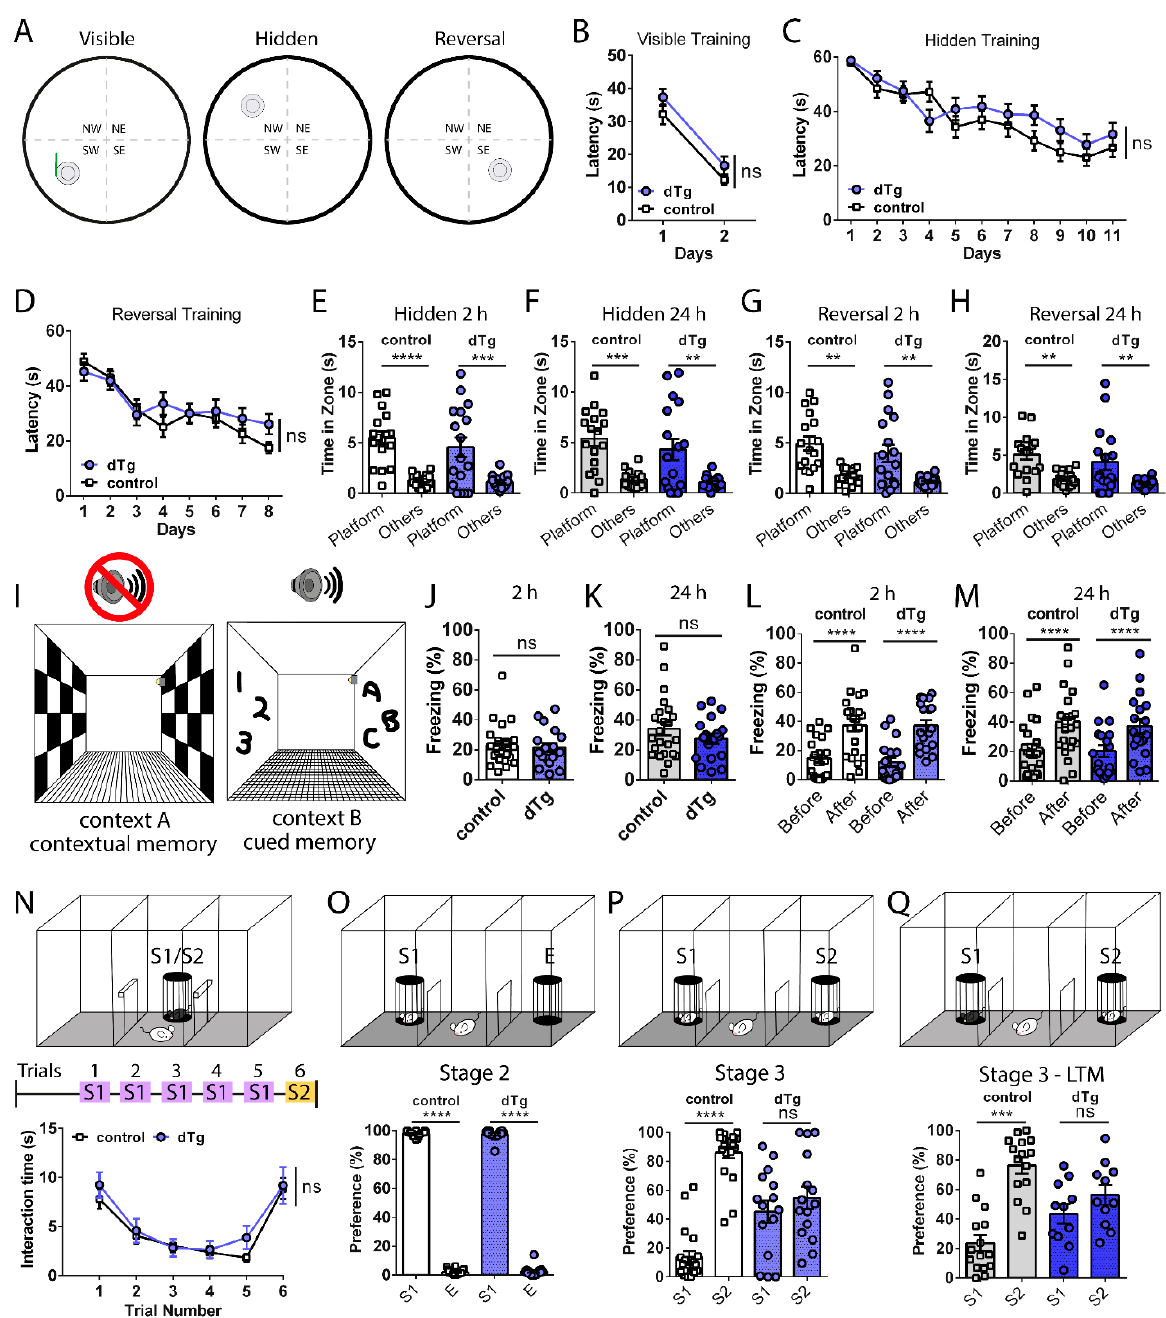
Figure 4. Impaired social recognition memory in three-chamber social tests, but normal spatial and fear learning and memory, in dTg mice. ( A ) Schematics of visible, hidden, and reversal MWM training layout. No differences between control ( n = 19) and dTg ( n = 22) mice in escape latency during ( B ) visible platform (F (1,39) = 143.7; p < 0.0001, post hoc control p < 0.0001, dTg p < 0.0001; between genotypes F (1,39) = 2.280; p = 0.1391), ( C ) hidden platform (between genotypes F (1,39) = 0.9090; p = 0.3463), and ( D ) reversal platform (between genotypes F (1,39) = 0.3892; p = 0.5364). No differences between control ( n = 17) and dTg ( n = 17) mice during the hidden platform probe memory tests at ( E ) 2 h (F (1,32) = 41.77; p < 0.0001, post hoc control p < 0.0001, dTg p = 0.0003; between genotypes F (1,32) = 0.8153; p = 0.3733, post hoc platform p = 0.4650) and ( F ) 24 h (F (1,32) = 28.65; p < 0.0001, post hoc control p = 0.0004, dTg p = 0.0019; between genotypes F (1,32) = 1.264; p = 0.2692, post hoc platform p = 0.4308) or reversal platform probe tests at ( G ) 2 h (F (1,32) = 26.16; p < 0.0001, post hoc control p = 0.0012, dTg p = 0.0017; between genotypes F (1,32) = 2.325; p = 0.1372, post hoc platform p = 0.4064) and ( H )24 h (F (1,32) = 19.92; p < 0.0001, post hoc control p = 0.0038, dTg p = 0.0062; between genotypes F (1,32) = 1.709; p = 0.2004, post hoc platform p = 0.4709). ( I ) Schematics of context A and B used for fear conditioning. ( J ) Short ‐ term 2 h contextual t (39) = 0.3345, p = 0.7398, ( K ) long ‐ term 24 h contextual t (39) = 1.135, p = 0.2632, ( L ) short ‐ term 2 h cued F (1,39) = 154.8; p < 0.0001, post hoc control p < 0.0001, dTg